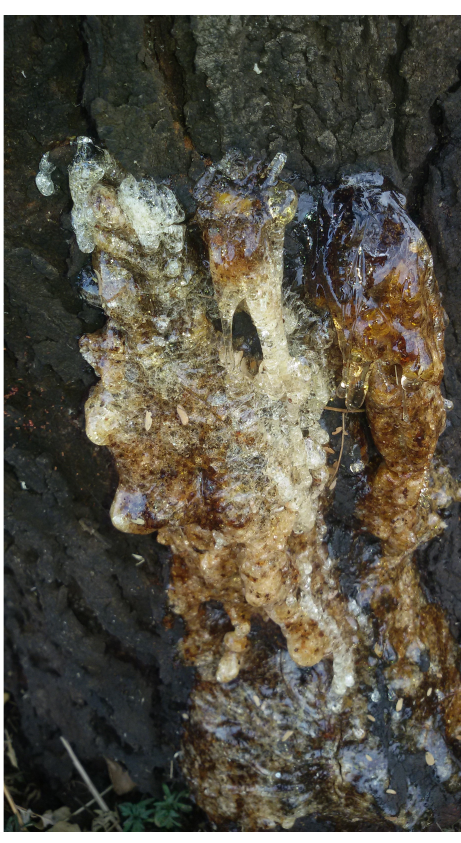
Figure 1. Gum karroo tears oozing from the bark.